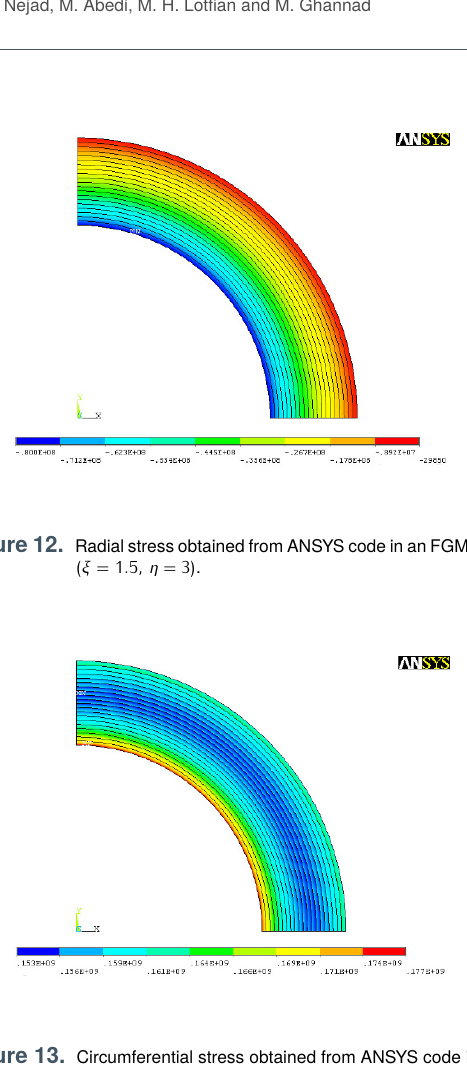
were considered for material inhomogeneity constants